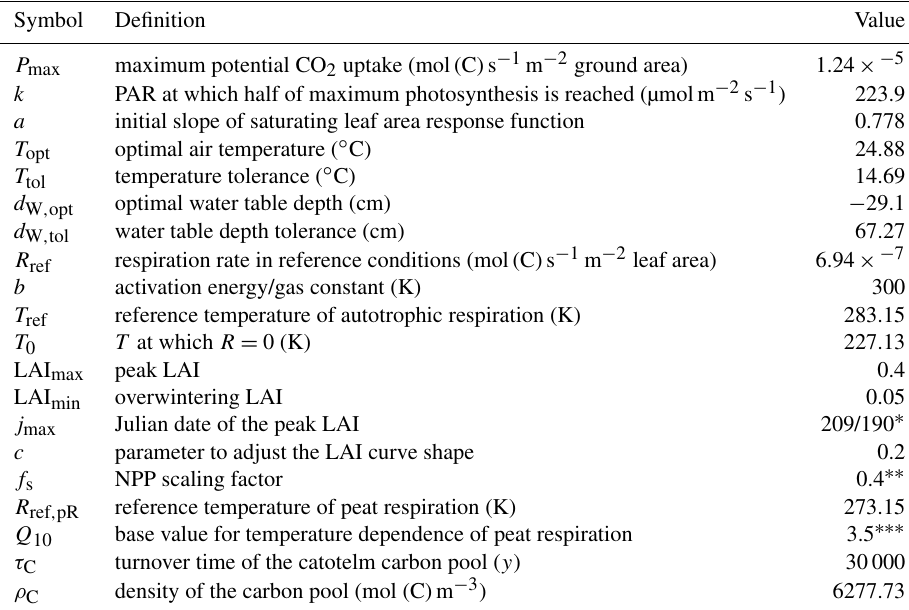
Table B1. Parameter values of the models used for producing input for the Siikaneva and Lompolojänkkä runs. The value marked with * is the only one specific for the Lompolojänkkä site. The parameter value marked with ** is fitted in this study, and the value *** is based on Szafranek-Nakonieczna and Stepniewska (2014); the others are from the original references of the photosynthesis and respiration